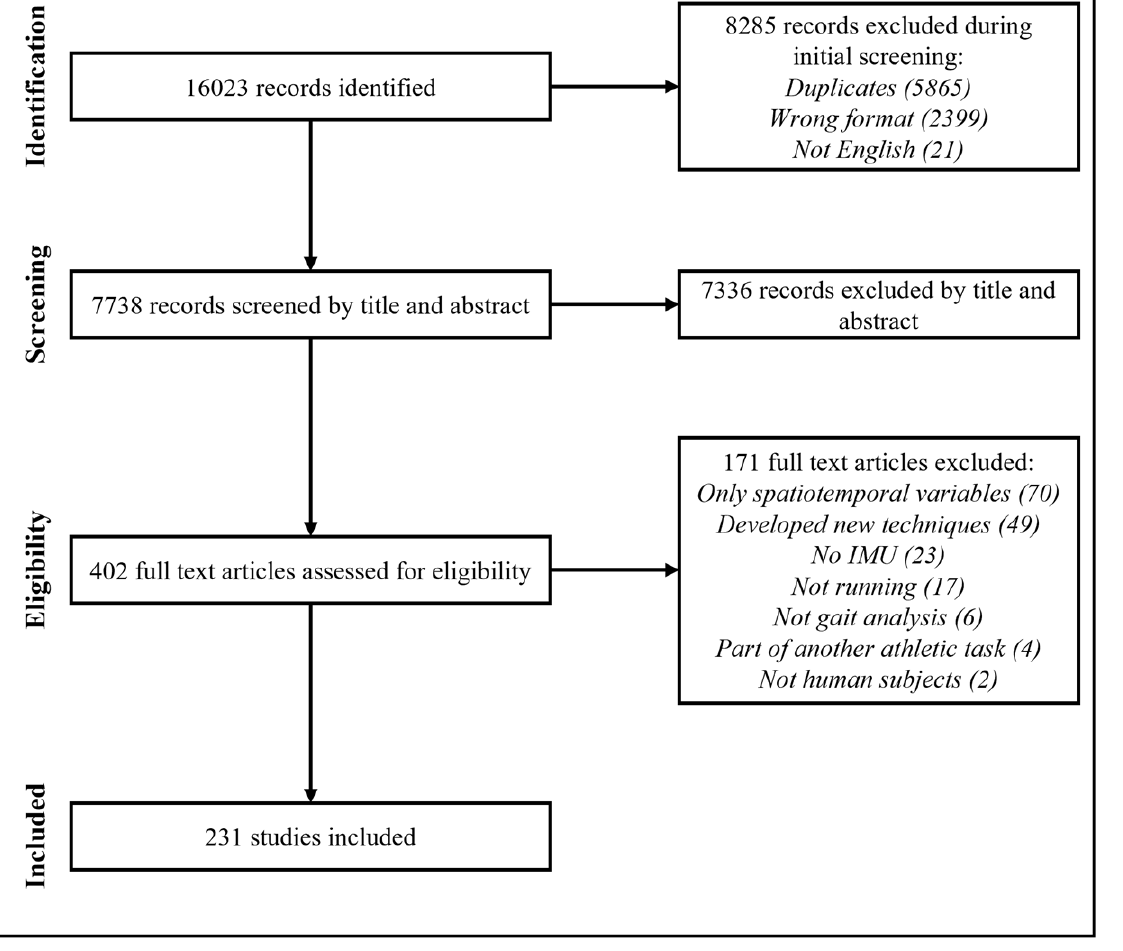
Figure 1. Flowchart of the study selection process.